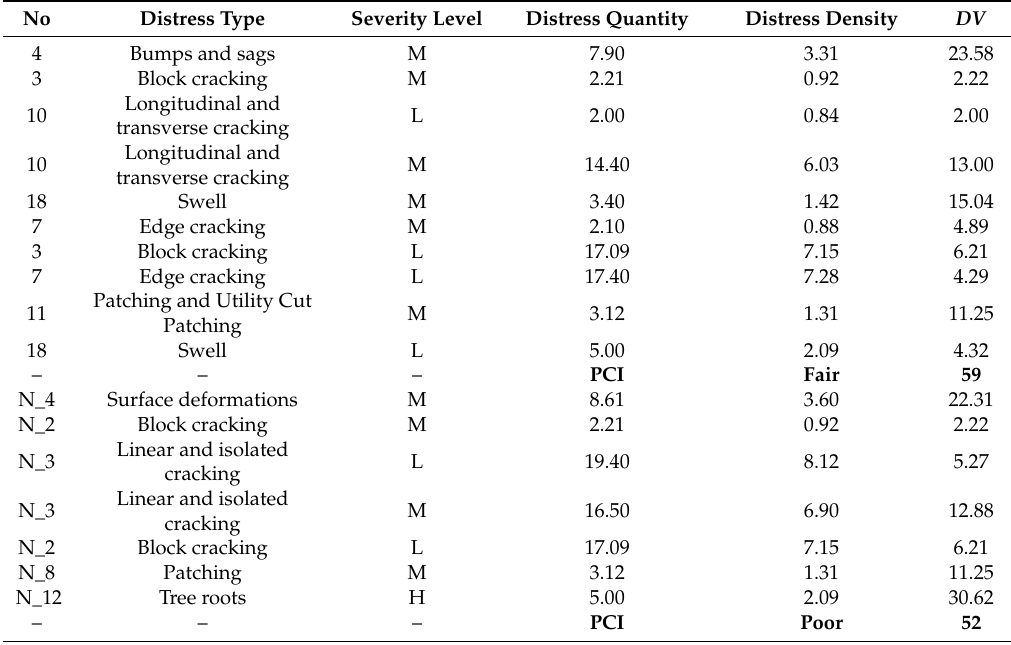
Table 9. Comparative analysis between ASTM D6433 and New Distress Identification Manual for Urban Pavements: N_12 Tree roots